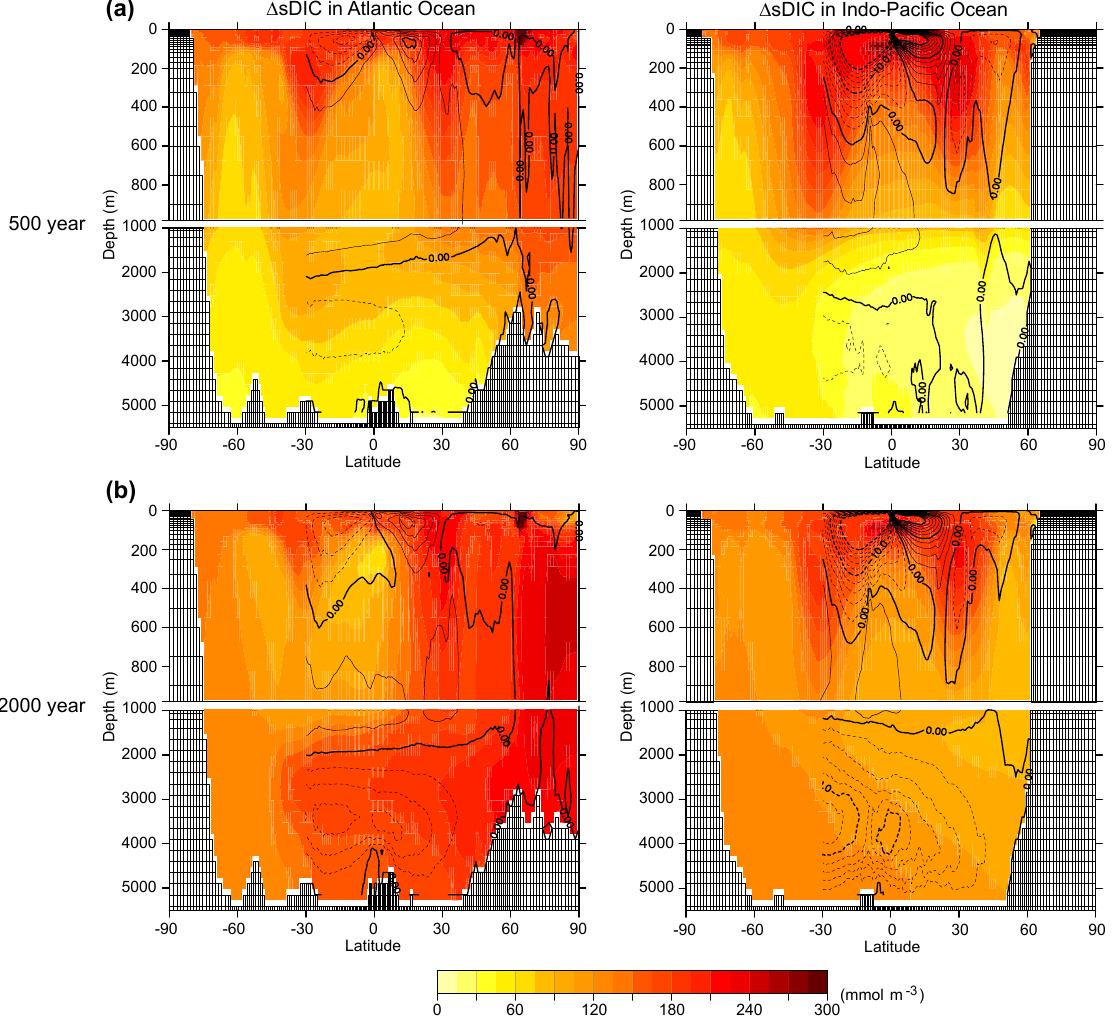
Figure 4. Zonal mean distribution of changes in the salinity-normalized DIC (colors) and meridional overturning stream function (contours) for (a) 500 years and (b) 2000 years in the global warming run (GW). The left and right panels show the Atlantic and Indo-Pacific oceans, respectively; contour interval is 2Sv